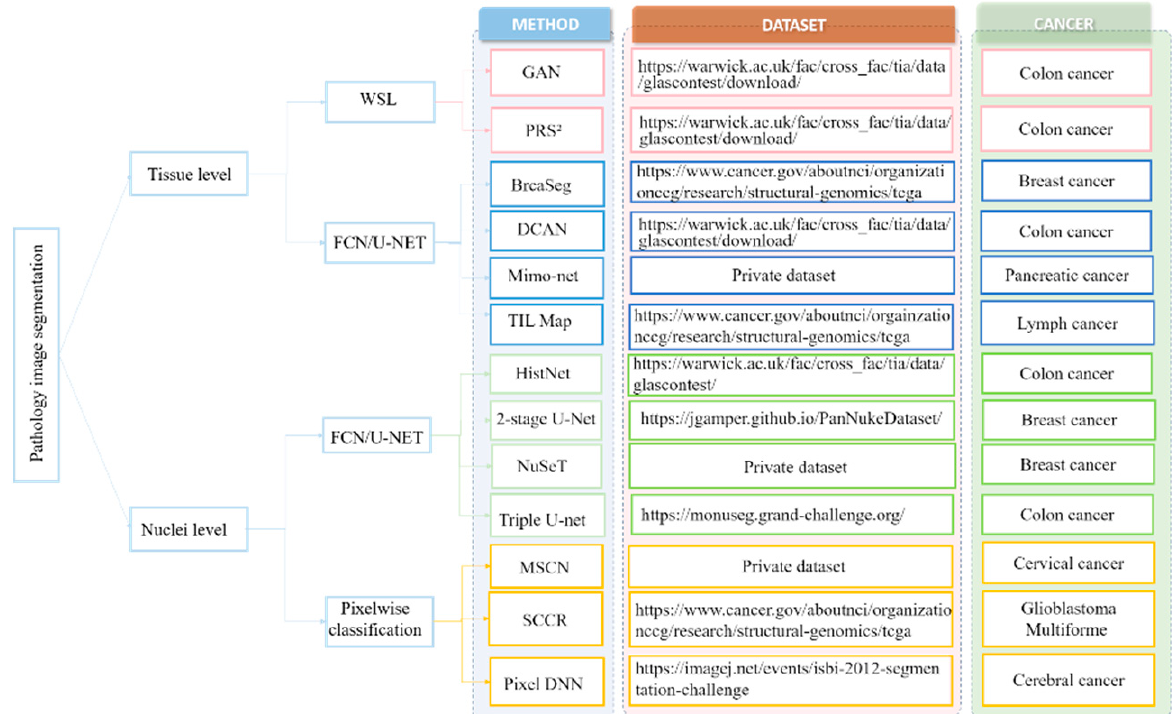
Figure 5. Overview of papers using deep learning for nuclei/tissue segmentation in histopathological images [51,53–64].